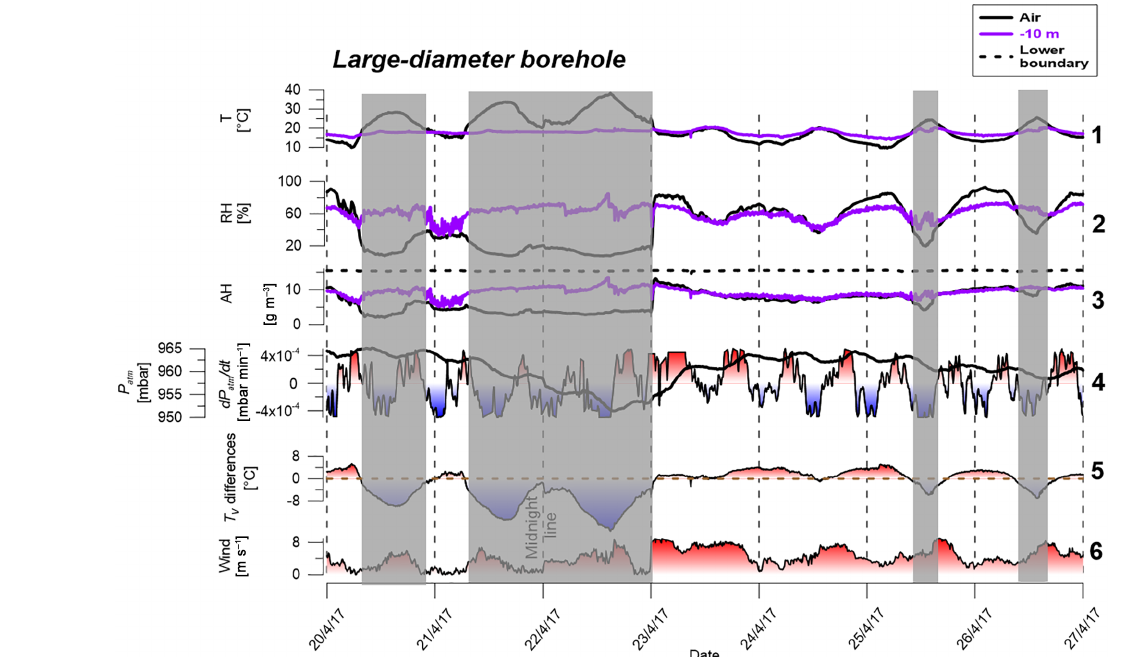
Figure 7. Time series results from the large-diameter borehole for 1 week. Gray columns represent periods of thermal stability inside the large-diameter borehole. Values in line 5 represent T v differences between 10m of depth and the air aboveground. T v values were calculated according to Sánchez-Cañete et al. (2013) using CO 2 concentrations of 2000 and 400ppm for 10m of depth and air aboveground,